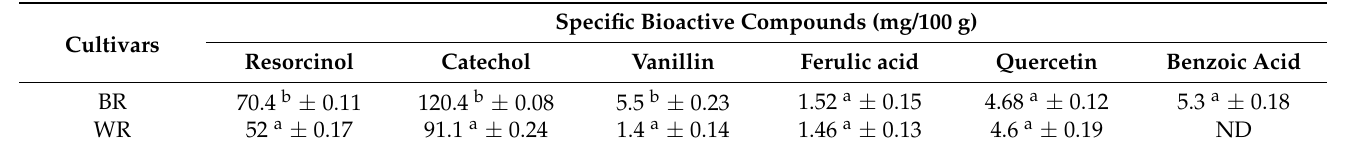
Table 2. Amount of specific compounds in aqueous extracts of different rye cultivars.